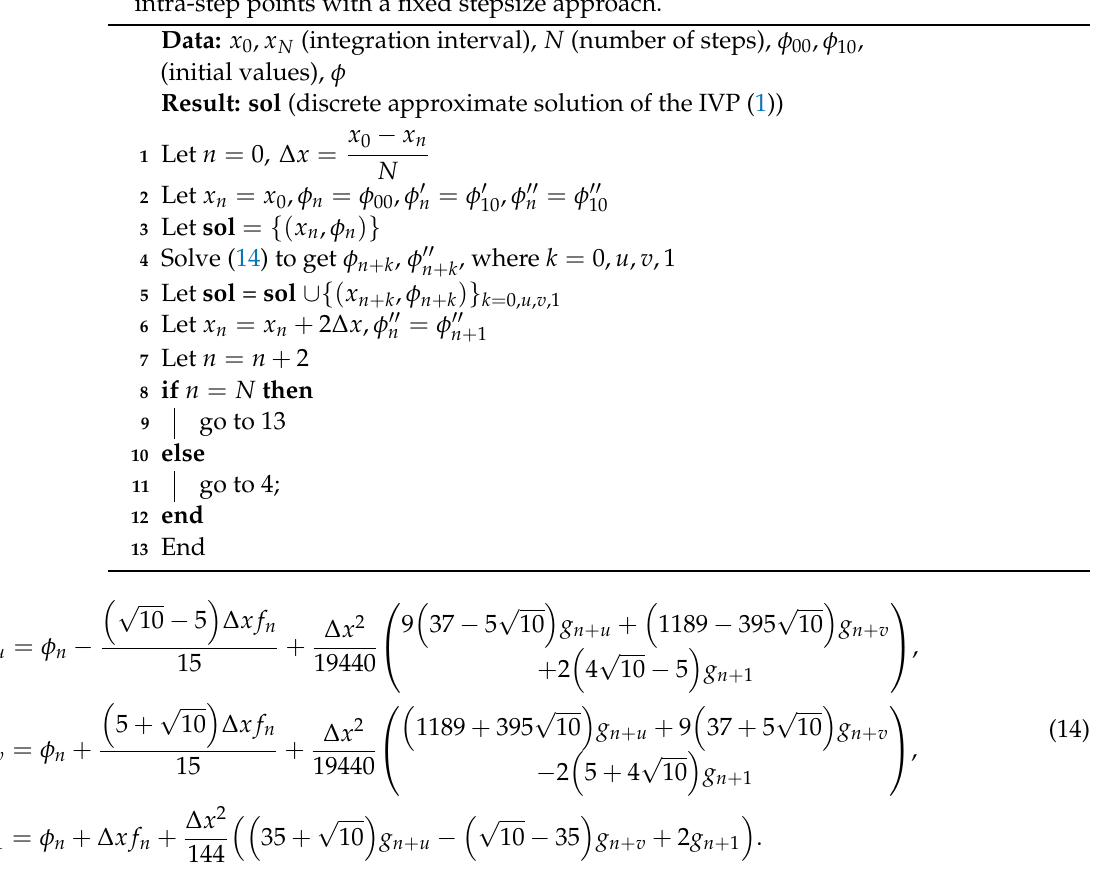
Algorithm 1: Pseudo-code for the optimized hybrid block technique with two intra-step points with a fixed stepsize